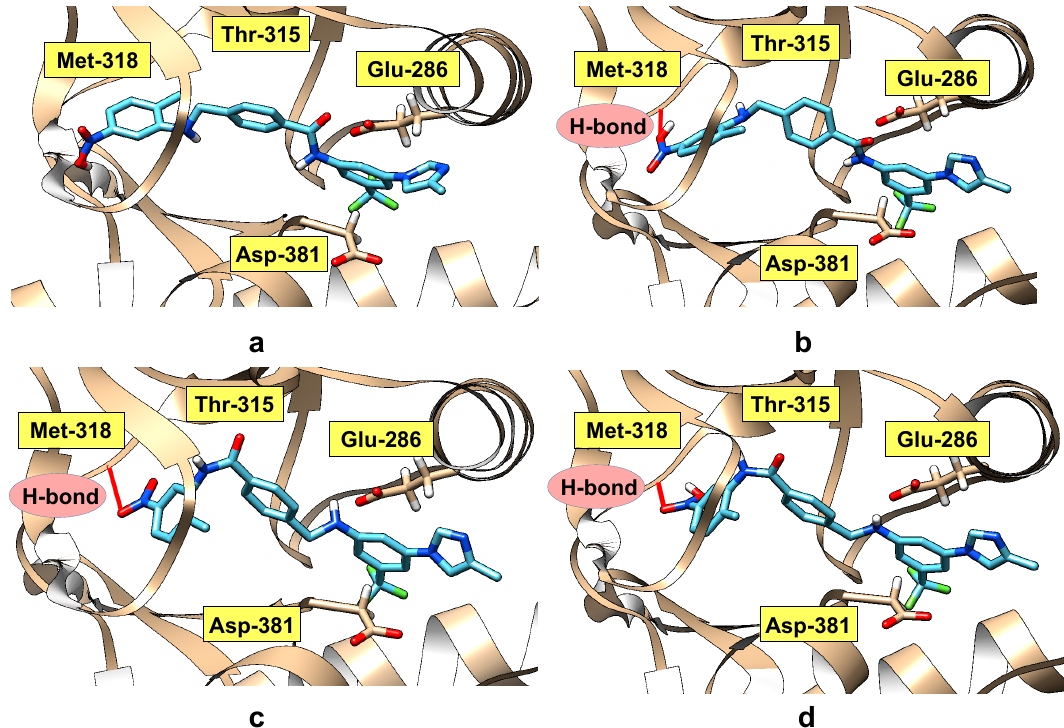
Figure 2 . Binding models of inhibitor 9 and 15 to Abl-wt kinase (wild-type Abl structure). Hydrogen bonds (H-bonds) are indicated by red lines to key amino acids. ( a ) Binding model of 9 with Abl (Protein Data Bank (PDB): 3CS9; H-bond—non-detected). ( b ) Binding model of 9 with Abl (PDB: 2HYY; H-bond—Met-318). ( c ) Binding model of 15 with Abl (PDB: 3CS9; H-bond—Met-318). ( d ) Binding model of 15 with Abl (PDB: 2HYY;